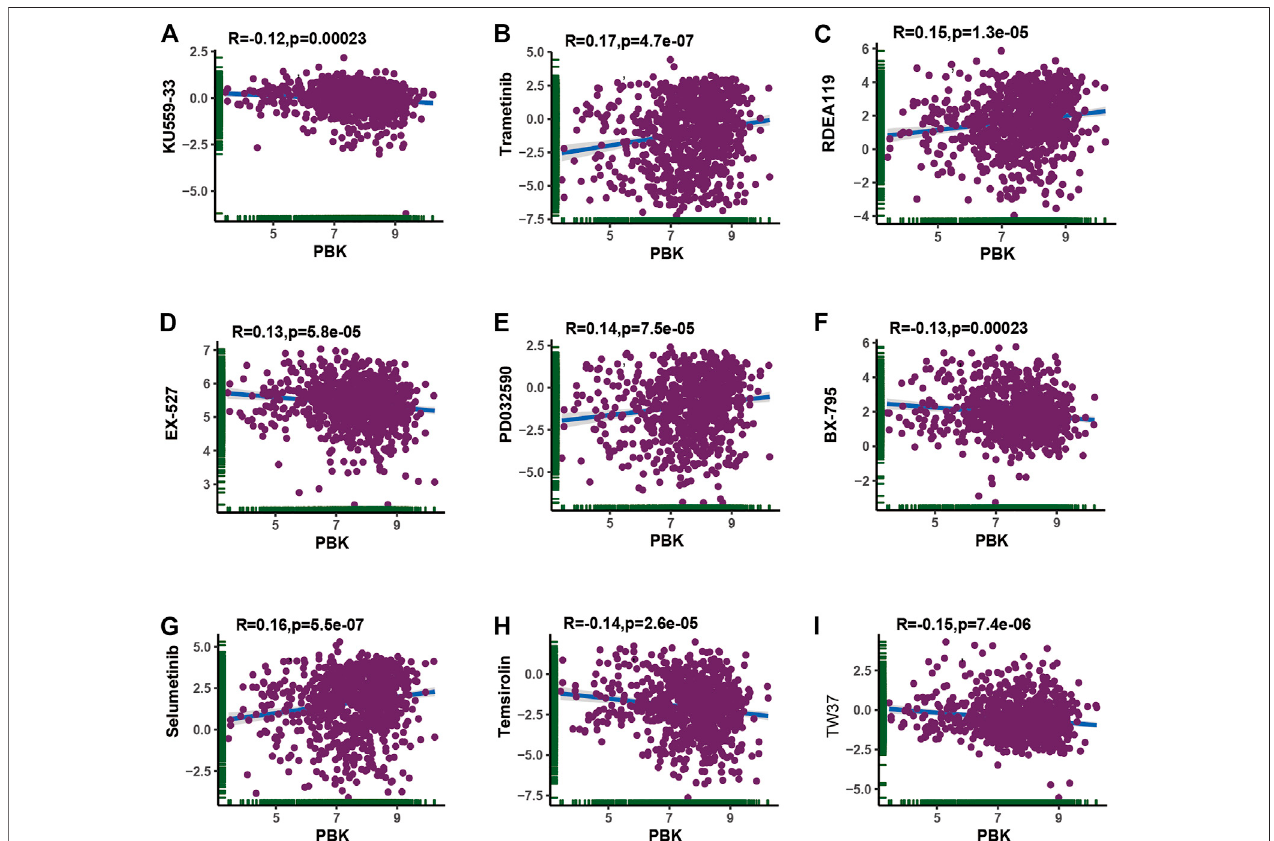
FIGURE 11 | | Correlation of sensitivity to chemotherapy (IC50) with PBK